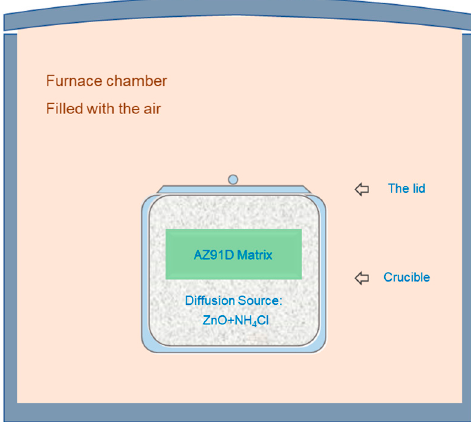
Figure 2. Schematic diagram to show the diffusion system, ZnO was the only Zn donor in the diffusion source, and the diffusion alloying process was carried out directly in the air.